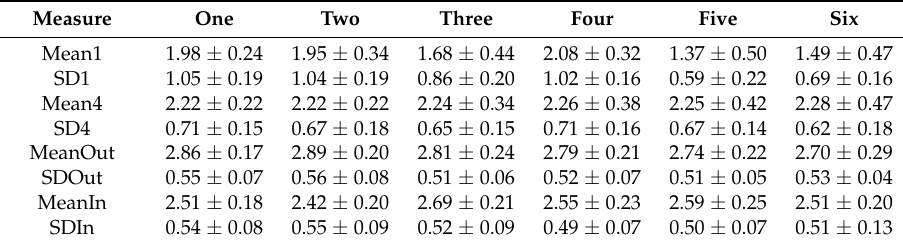
Table 1. Mean ± SD of the pen values used to generate the random individual-bird dataset 1